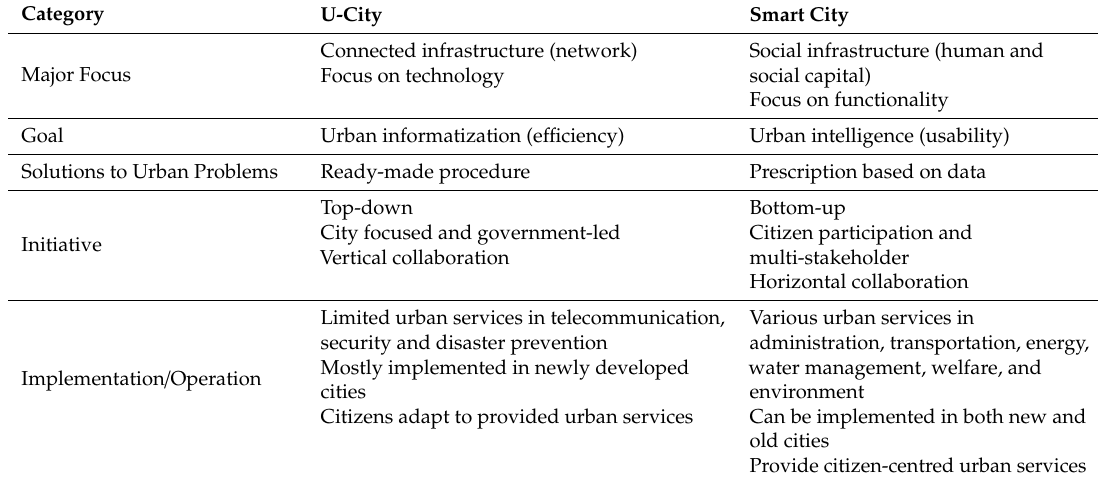
Table 4. Di ff erences between U-City and Smart